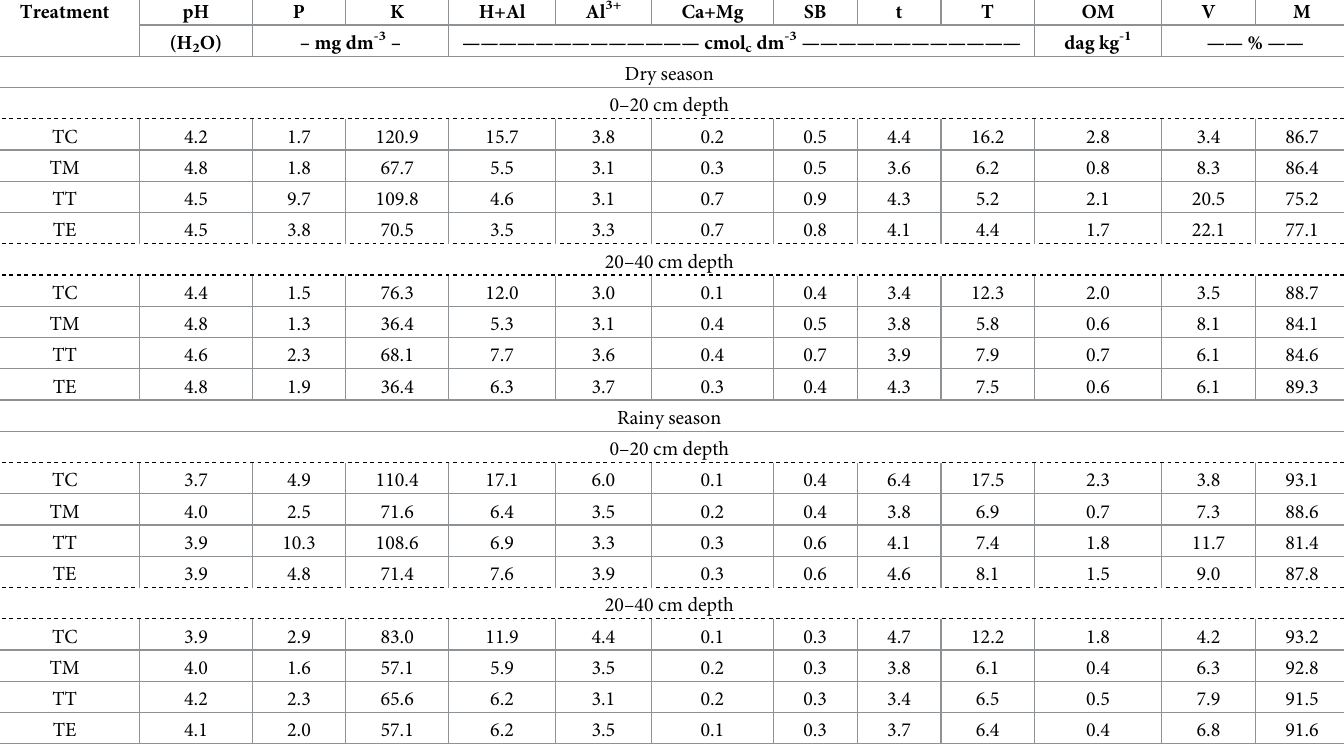
Table 3. Chemical characteristics of the soil under the Cerrado and different types of gravel substrate collection points at two depths and two stations, Paracatu- MG. Treatment